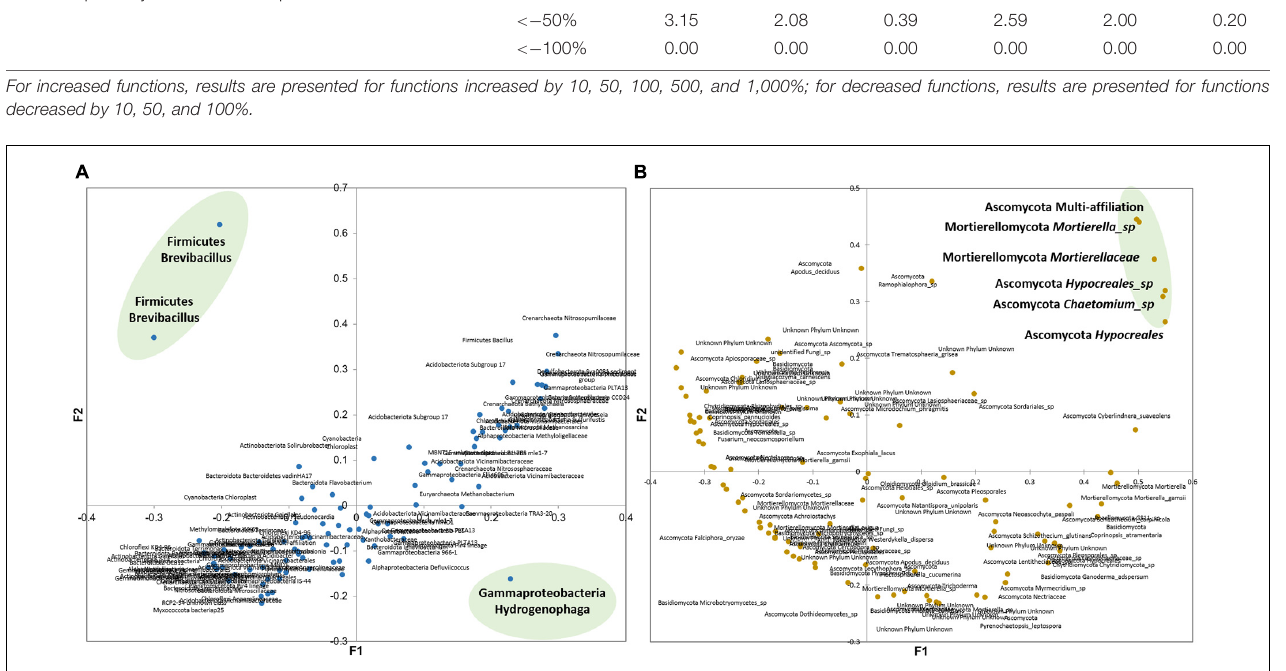
Percentage among the 3,554 metabolic